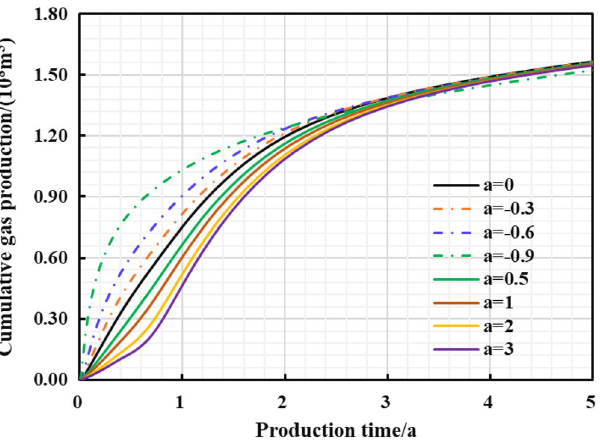
Figure 33. The cumulative gas production and time chart in the early stage of production.